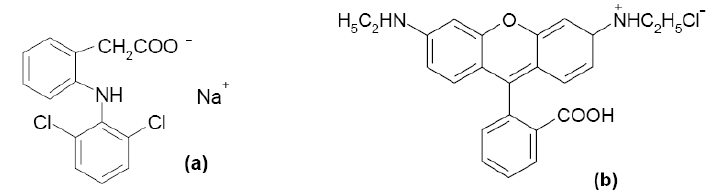
Fig. 1 (a) - diclofenac, (b) - Rhodamine